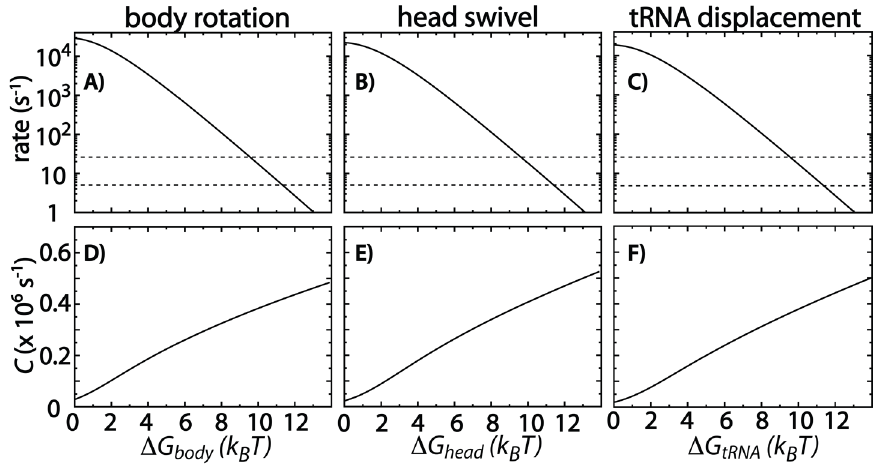
, D eff , and D eff , the rates of barrier crossing were tRNA body head